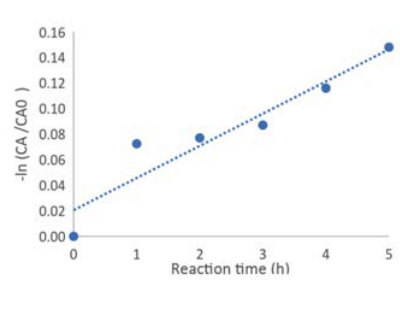
Figure 4. Relationship between –ln C vs